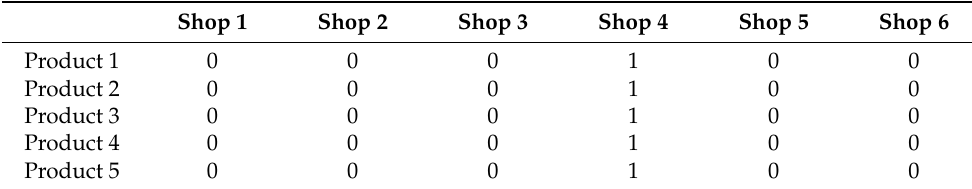
Table 6. The result of numerical solution (products).